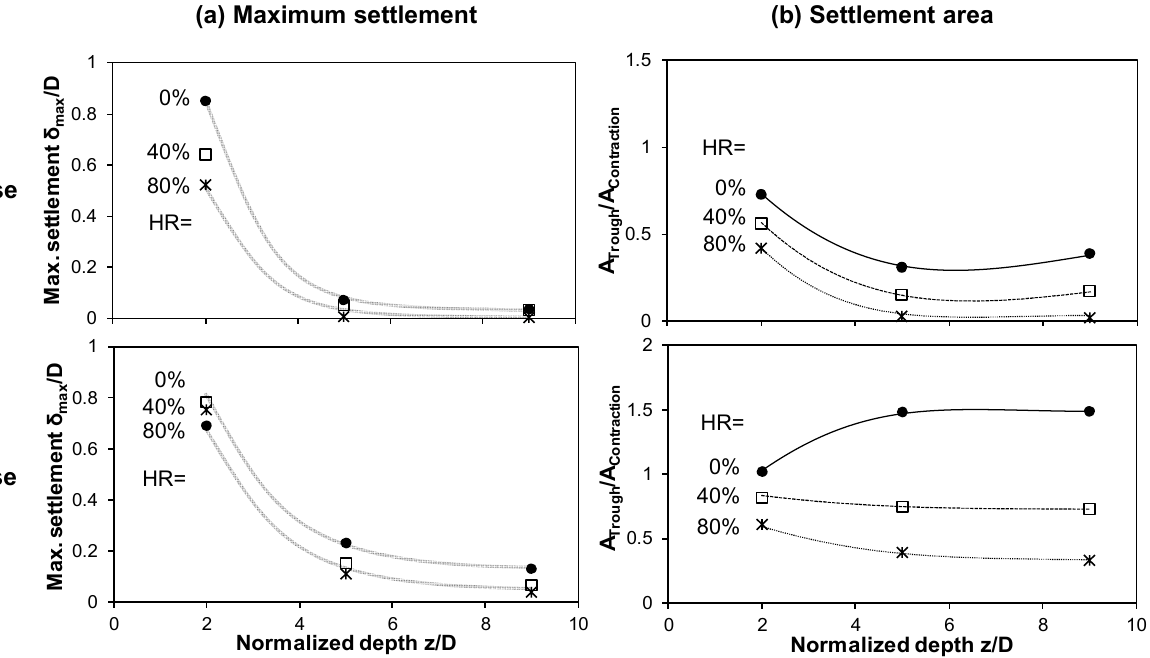
Figure 6. Surface settlement for subsurface cavity dissolution in dense and loose sediments. ( a ) Normalized maximum settlement δ max to inclusion diameter D. ( b ) Trough area A tr normalized by the area of contracting zone A cz